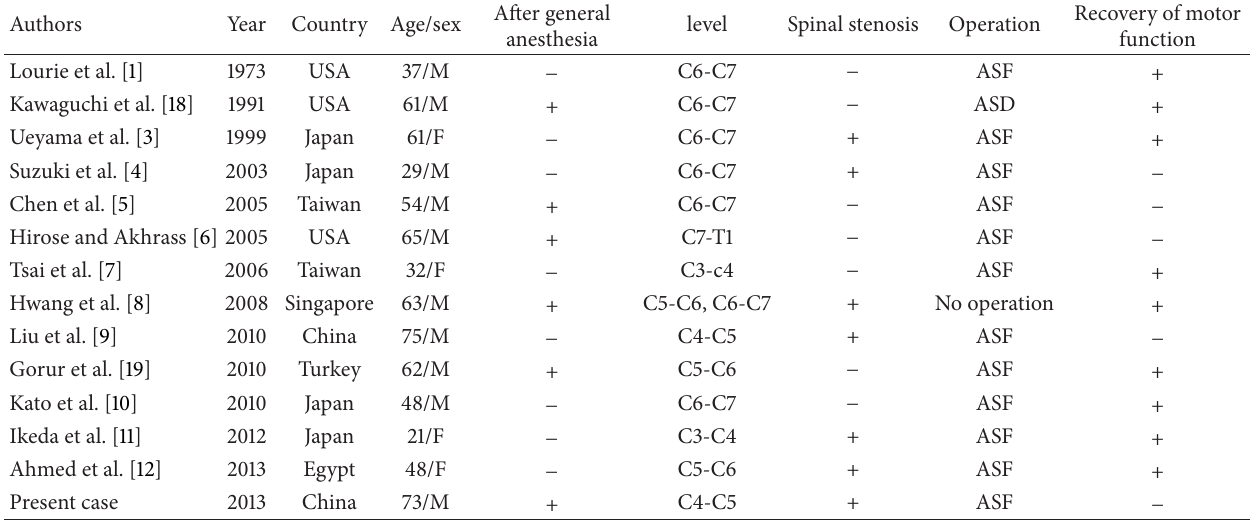
Table 1: Reported cases of nontraumatic acute myelopathy due to cervical disc herniation.